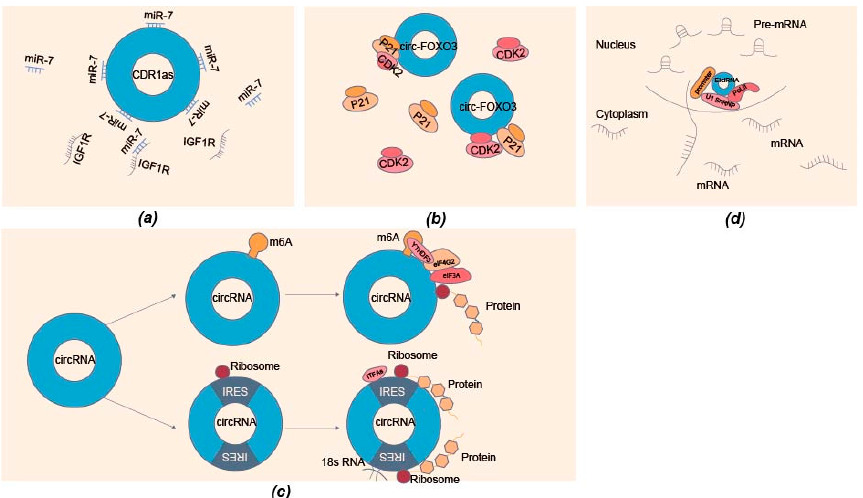
Figure 2. Regulatory mechanisms of circRNAs. ( a ) miRNA sponge: circRNAs can function as miRNA sponges. For example, circRNA CDR1as downregulates insulin-like growth factor 1 receptor (IGF1R) expression by acting as a sponge or inhibitor of miR-7. ( b ) Interactions with proteins: circ-Foxo3 forms ternary complexes with p21 and CDK2. ( c ) Protein translation: circRNAs have the translation potential by relying on IRES and/or m6A-mediated translation. ( d ) Transcription regulation: circRNA can regulate transcription to affect gene expression. For example, EIciRNA, U1 snRNP and Pol II may interact in the promoter region of the parent gene to affect parental gene expression.